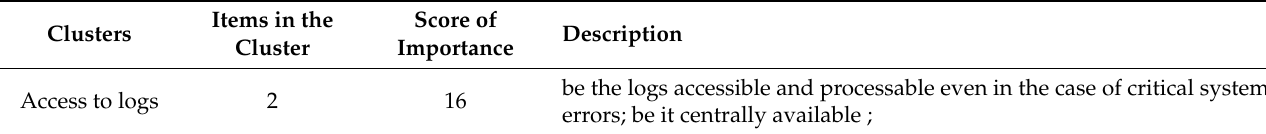
Table A2. Output of Data Coding Cycle Two, Merged Descriptions by